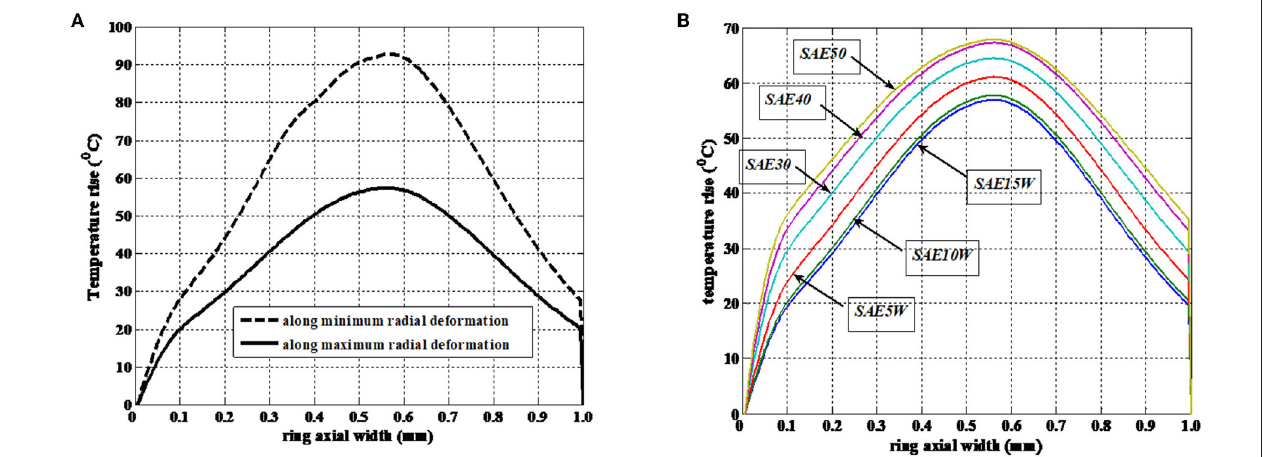
FIGURE 11 | (A) Temperature rise variation due to radial deformation ( θ c oil type ( θ c 273 ◦ , P com 120 bar, η 0 0.004 PaS, U = = =